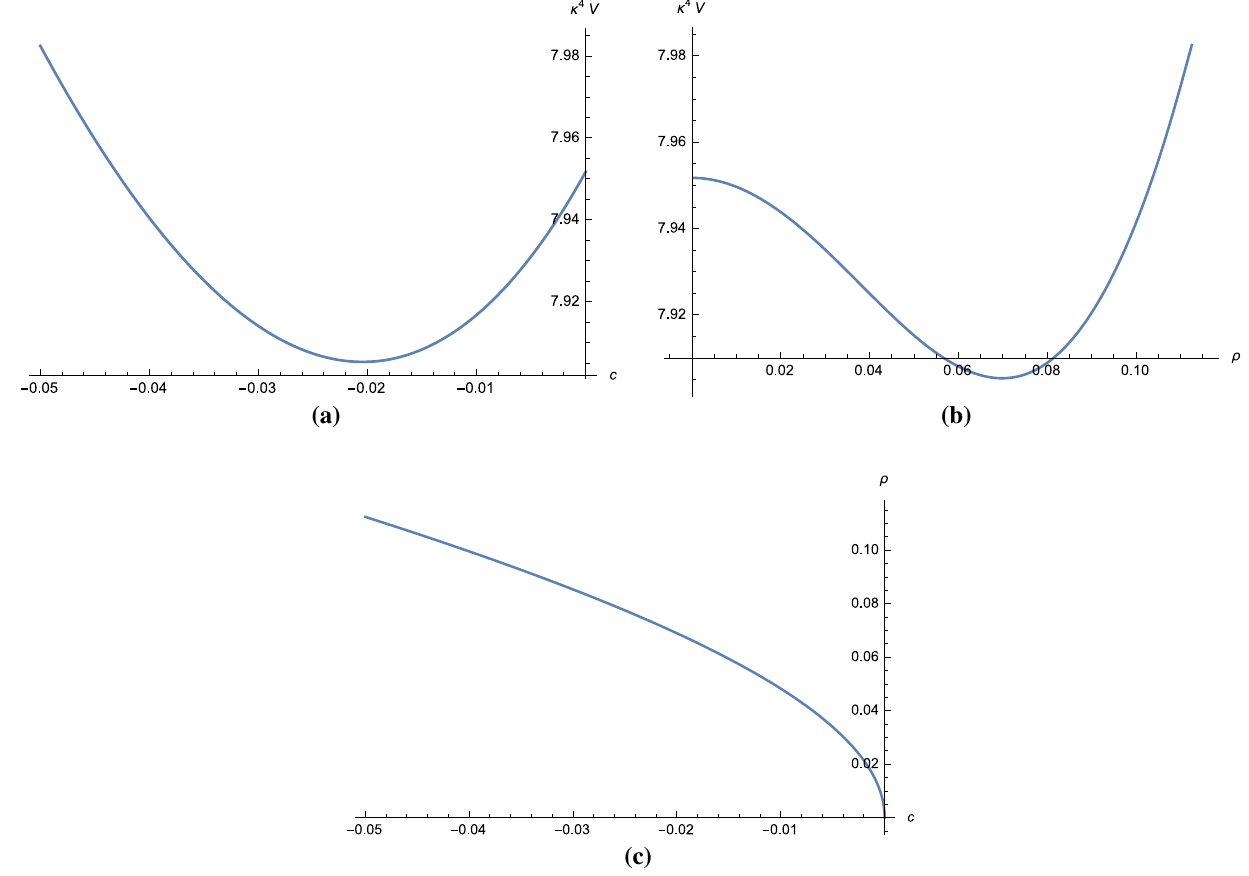
Fig. 3 The scalar potential for a model in Region II of Fig. 1 with parameters (5.31) is plotted as a function of c and ρ coordinates in a , b , respectively. Plot in c shows the relation between ρ and